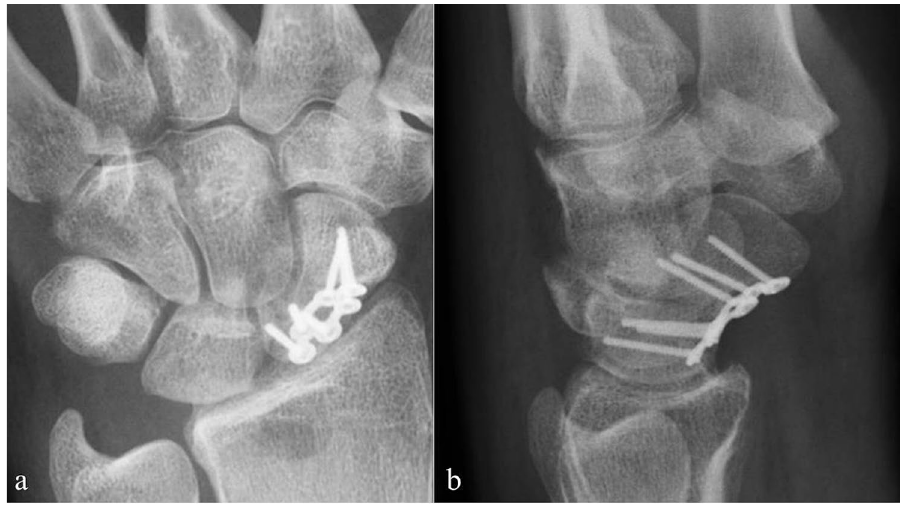
Figure 2. Control X-ray anteroposterior ( a ) and lateral ( b ) with the consolidation of the right scaphoid 6 months